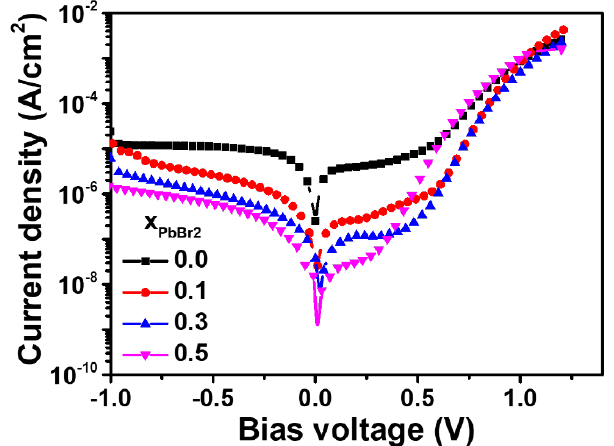
Figure 8. Plots of dark J-V curves for the solar cells fabricated at x = 0, 0.1, 0.3, and 0.5.